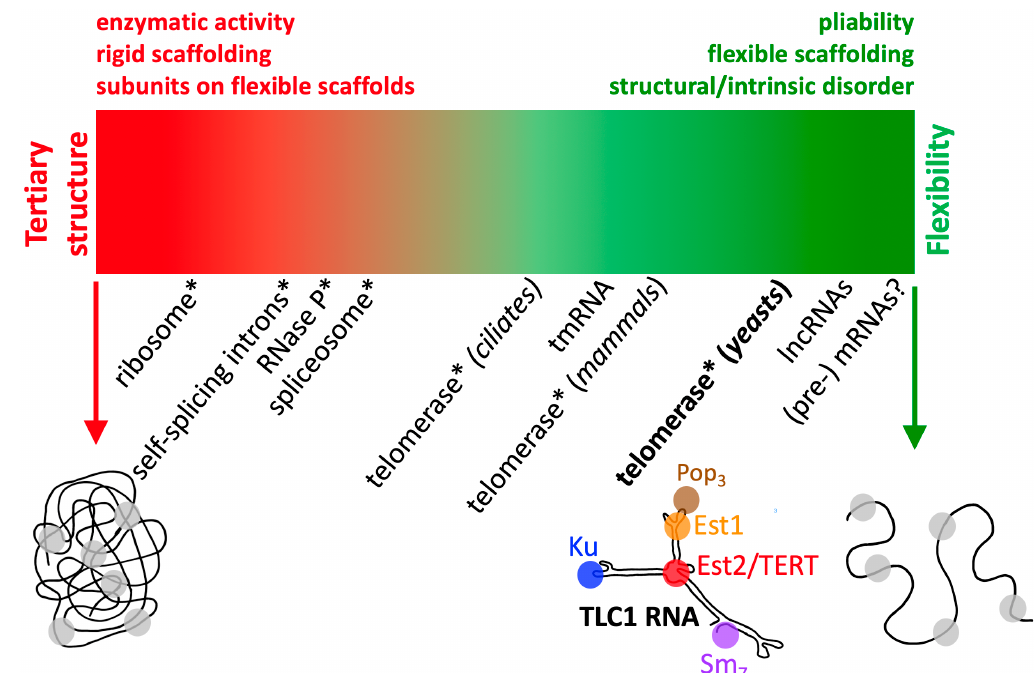
Figure 2. Physical organization of large RNA-protein complexes along a flexibility continuum. An extreme hypothetical structured and floppy RNP scaffolded by RNA is shown on each end of the continuum. Noncoding RNAs that bind to proteins in RNPs (in a broad sense of defining an RNP) are listed below the continuum based on where one might plot them on the flexibility spectrum.